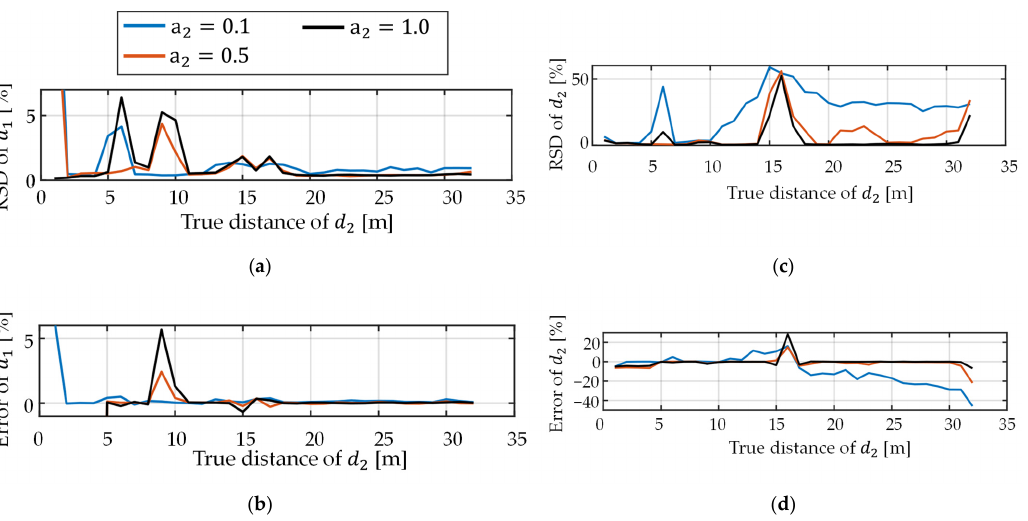
Figure 10. Results of dual-path simulations when depth-dependent decay of the number of photons was considered in Type B. N op was set to 5000 at 4 m for the amplitude of 1. ( a ) Relative standard error and ( b ) relative mean error of d 1 . ( c ) Relative standard error and ( d ) relative mean error of d 2